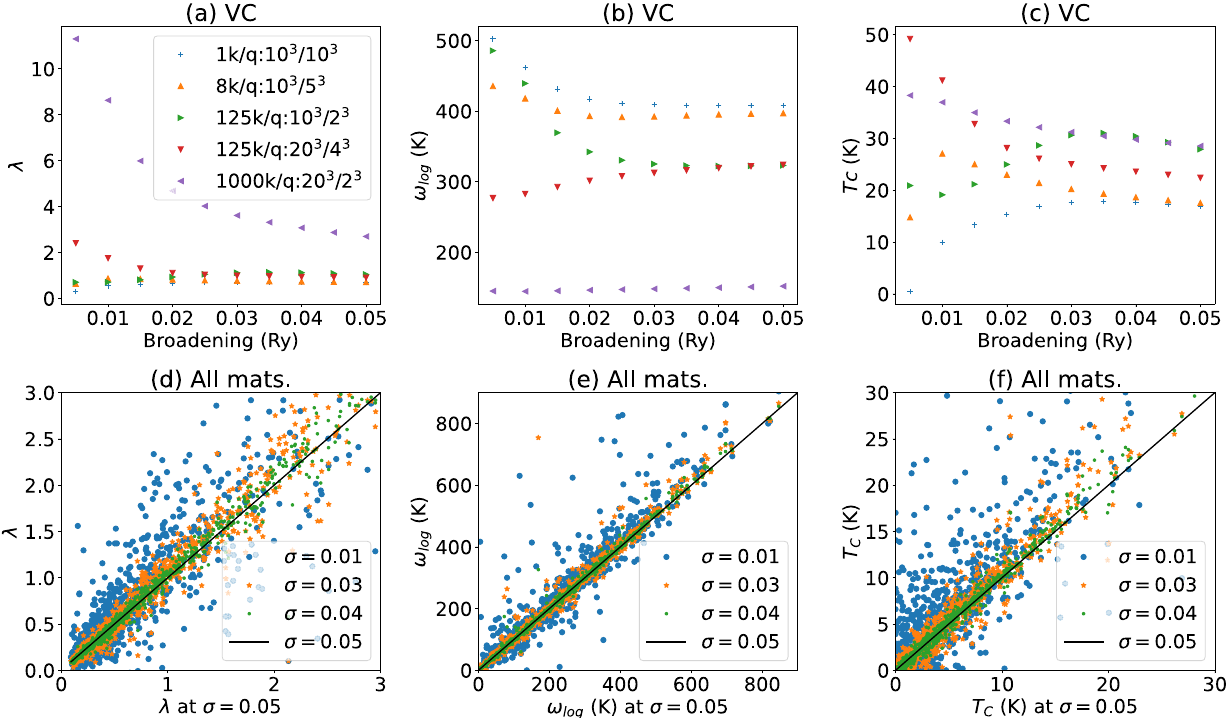
Fig. 2 Effect of different k-point and q-point selection on EPC parameters for VC. a λ , b ω log , c T C . Broadening dependent scaled d λ , e ω log and f T C for the all the systems in the database. The scaling was done with respect to the corresponding values at broadening of 0.05 Ry. The legend in a corresponds to the number of k-points and q-points, e.g., 10 × 10 × 10 k-points and 10 × 10 × 10 q-points (denoted by black star) is same as 1 k-point per q-point; and 20 × 20 × 20 k-point and 2 × 2 × 2 q-point correspond to 1000 k-point per q-point (denoted by left purple